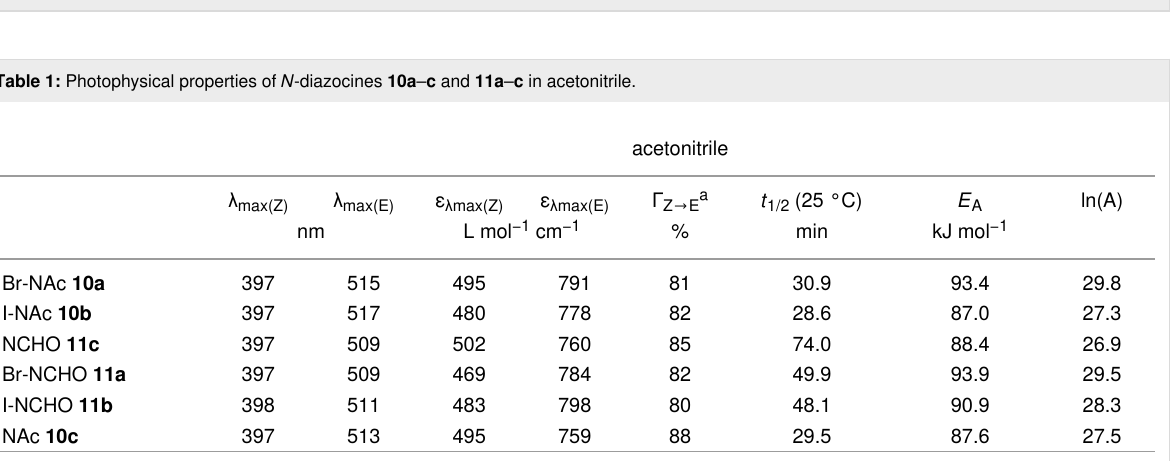
Figure 2: UV–vis spectra of 3-bromo and 3-iodo, and unsubstituted CH 2 NAc-bridged ( 10a – c ) and CH 2 NCHO-bridged ( 11a – c ) diazocines. The spec- tra of Z -isomers are given in black, the photostationary states at 400 nm are represented as dashed red lines and the extrapolated spectra of the pure E -isomers are in blue.